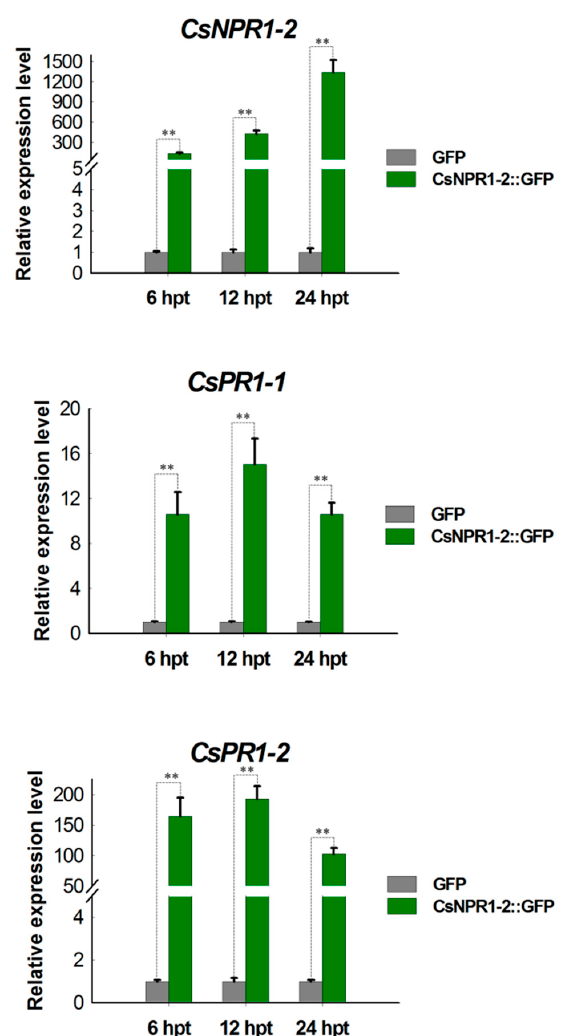
Figure 8. Regulation analysis of CsNPR1-2 protein on expression of CsPR1 genes by qRT-PCR. Protoplasts transiently expressing fusion protein CsNPR1-2::GFP were collected at 6, 12 and 24 hpt, and the expression of CsPR1-1 and CsPR1-1 genes were examined by qRT-PCR. Y-axes indicate the relative expression levels; significant di ff erence was assessed by Mann–Whitney U-test and indicated by asterisks; single asterisk (*) represents p ≤ 0.05, double asterisk (**) represents p ≤ 0.01; data are expressed as the mean of three biological replicates, with error bars indicating the SD.